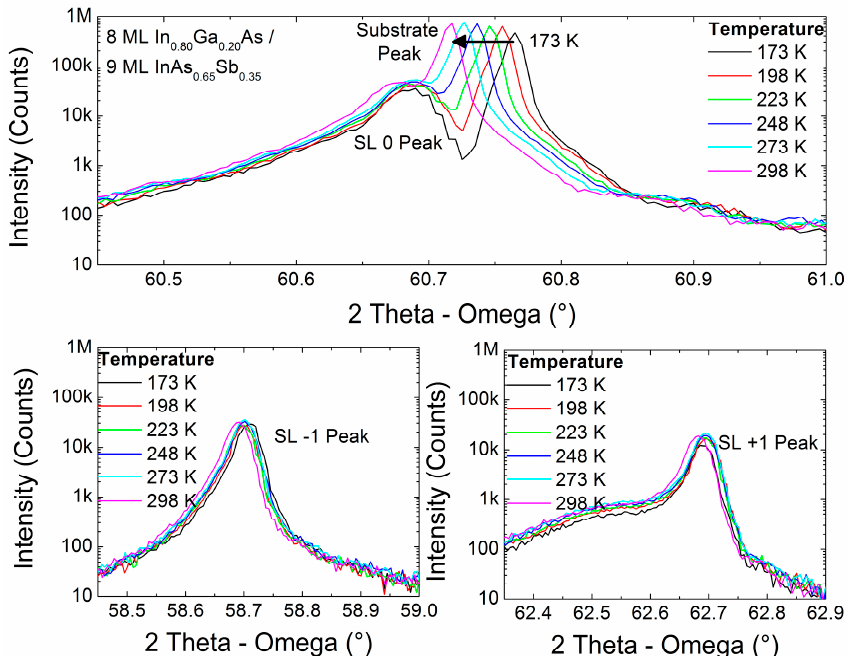
Figure 2. (Upper frame) XRD scans of the substrate and InGaAs/InAsSb SL 0 peak from 173–298 K. The substrate and superlattice remain compressively strained throughout. (Lower left frame) The SL − 1 peak of the superlattice. The peak location does not change monotonically. (Lower right frame) The SL +1 peak of the superlattice. The peak behaves similarly to the SL − 1 peak.